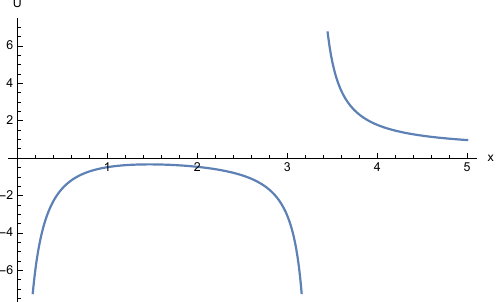
Figure 8. Plot of < U ( x ) > for x = β G = m = R 1 = M = 1. Remember that the results are unphysical for x < 3.35. The kinetic energy diminishes as x grows and so does the energy. However, R 1 is too large to allow for statistical bounding in the region here considered.